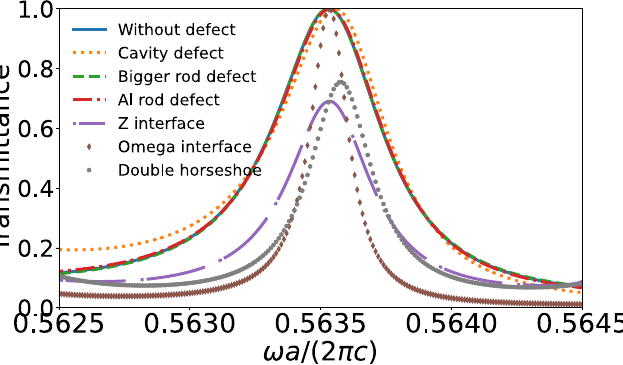
Figure 9. Transmittance spectrum for the cases without defect, cavity defect, larger rod defect, Al rod defect, Z interface, Omega interface and double horseshoe